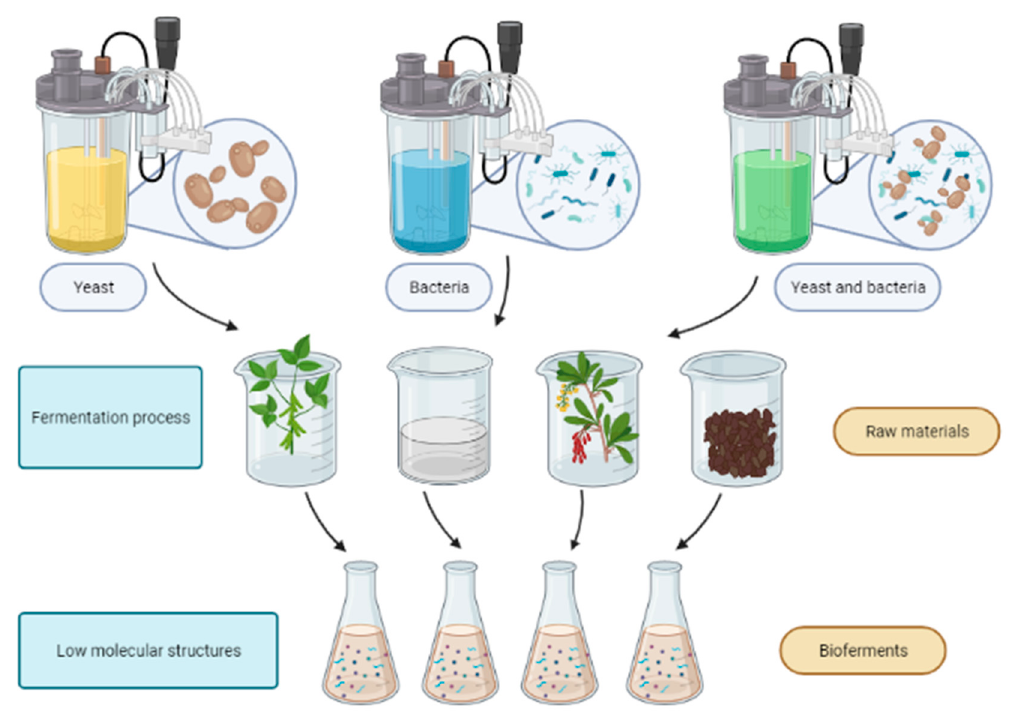
Figure 2. Schematic process of the biofermentation.